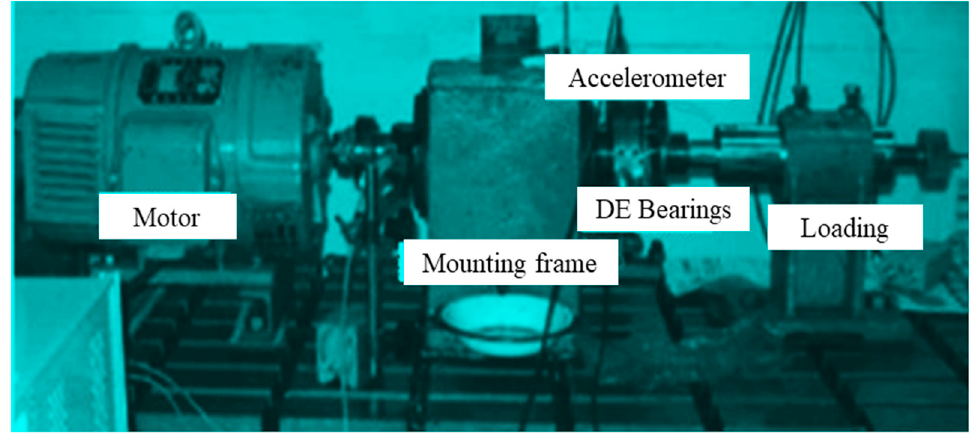
Figure 16. Practical rolling bearing fault data acquisition platform.